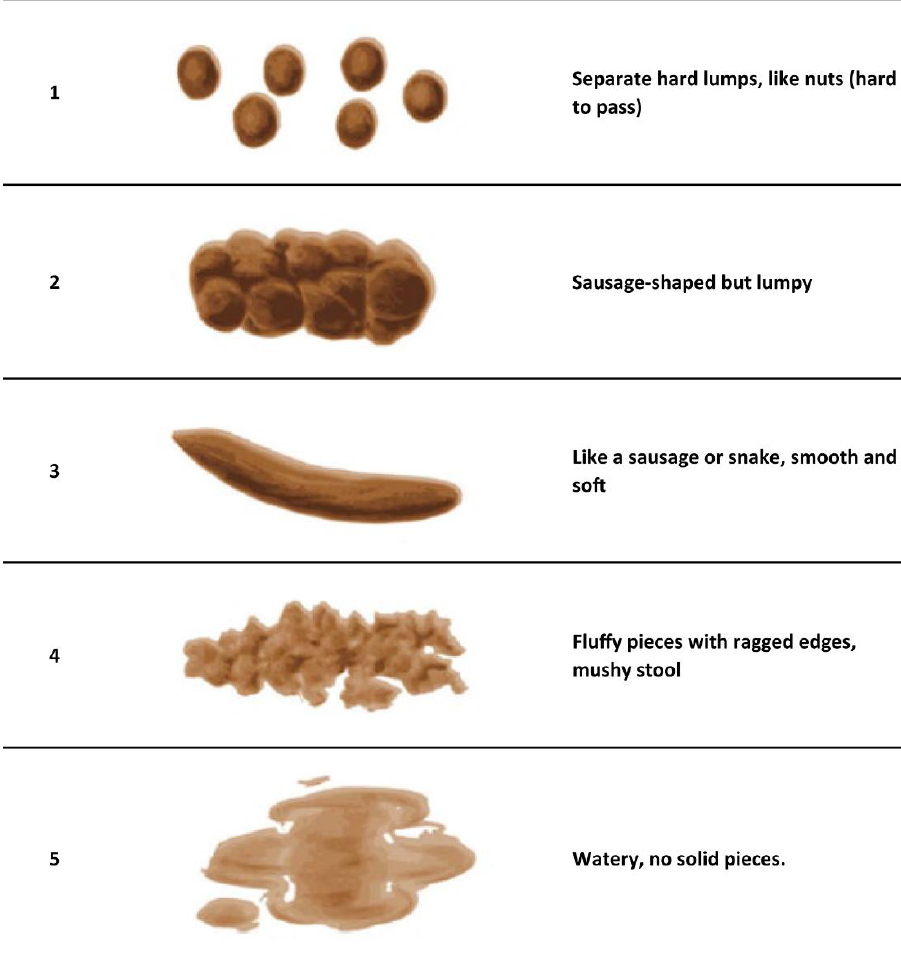
Figure 1. Stool types in the modified Bristol stool form scale for children (mBSFS-C [21], figure re- produced with